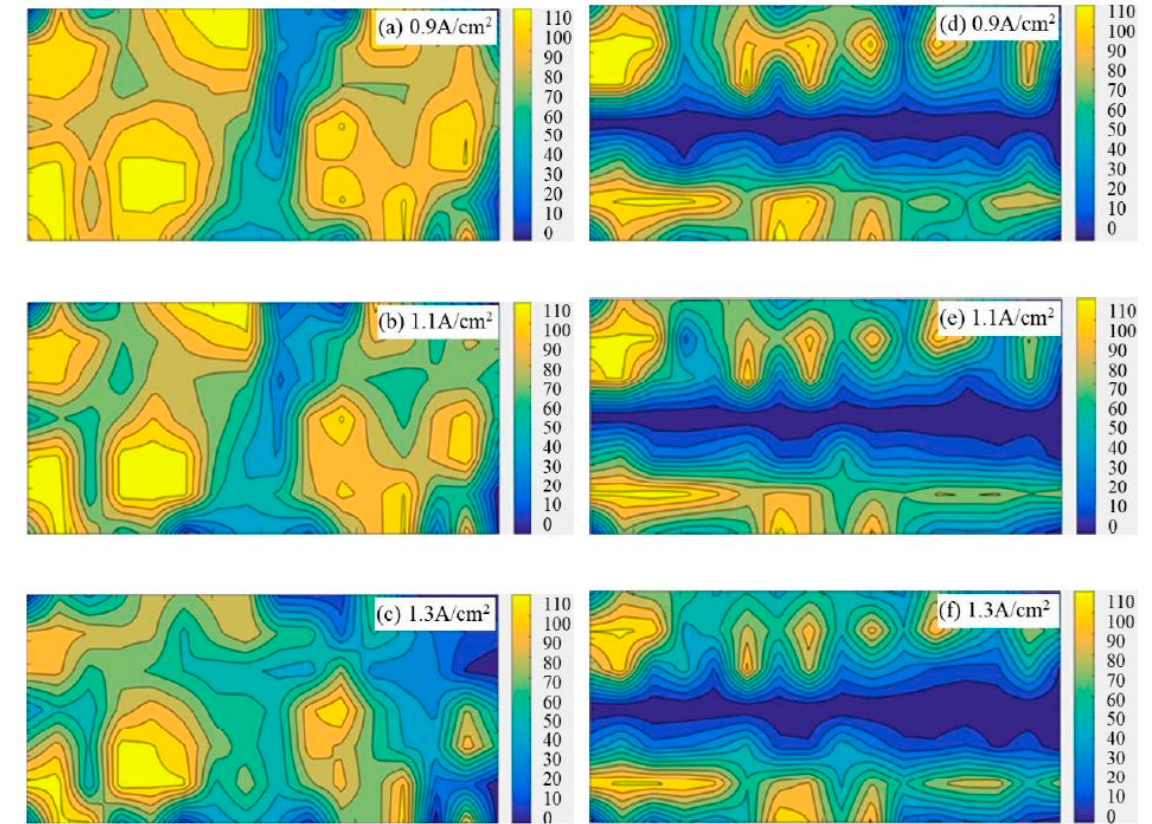
Figure 3. Accumulated bubble distribution patterns on the 50 mm × 22 mm flat and slotted anodes from statistical analysis within 60 s; the gradient bars indicate the number of occurrence of bubbles on the specific anode surface in the 121 images within 60 s. ( a ) Apparent current density 0.9 A ‧ cm − 2 , flat anode ( b ) 1.1 A ‧ cm − 2 , flat anode ( c ) 1.3 A ‧ cm − 2 , flat anode ( d ) 0.9 A ‧ cm − 2 , slotted anode ( e ) 1.1 A ‧ cm − 2 , slotted anode ( f ) 1.3 A ‧ cm − 2 , slotted anode.